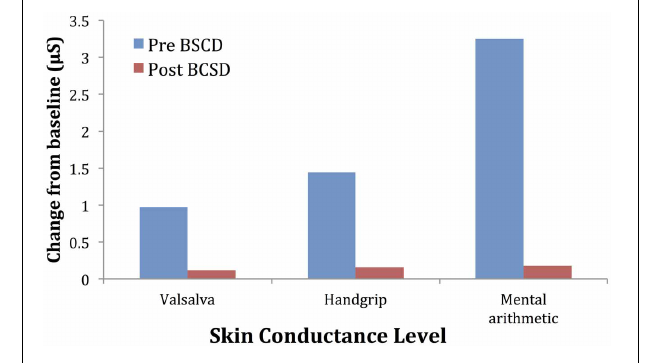
FIGURE 5 | Mean changes in systolic blood pressure from baseline during autonomic challenge before and after bilateral cardiac sympathetic decentralization (BCSD) in Case 2.